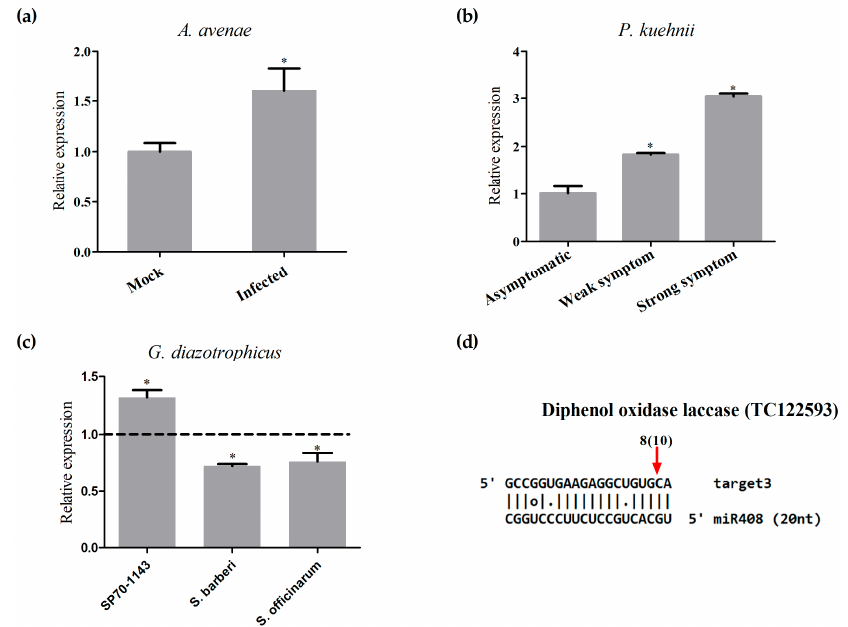
Figure 9. Regulation of laccase by miR408. ( a ) mRNA levels of the putative target of miR408 was analyzed by real-time PCR in mock-inoculated plants, Acidovorax avenae -infected plants; ( b ) using Puccinia kuehnii -infected plants that showed different degrees of symptoms in comparison to the expression in asymptomatic plants; and ( c ) using sugarcane hybrid SP70-1143 and two wild species inoculated with a beneficial diazotrophic bacteria, Gluconacetobacter diazotrophicus . Dotted line represents the expression of the control samples. The error bars represent the standard deviation between three technical replicates. * represents significant differences in expression between the control and inoculated samples for each experiment ( p -value < 0.05); ( d ) Alignment of miR408 and its putative target. The red arrow shows the cleavage site confirmed by 5 (cid:48) RACE (Rapid Amplification of cDNA Ends), and the number is the amount of clones that present this cleavage site (in parentheses) in a total of clones that were